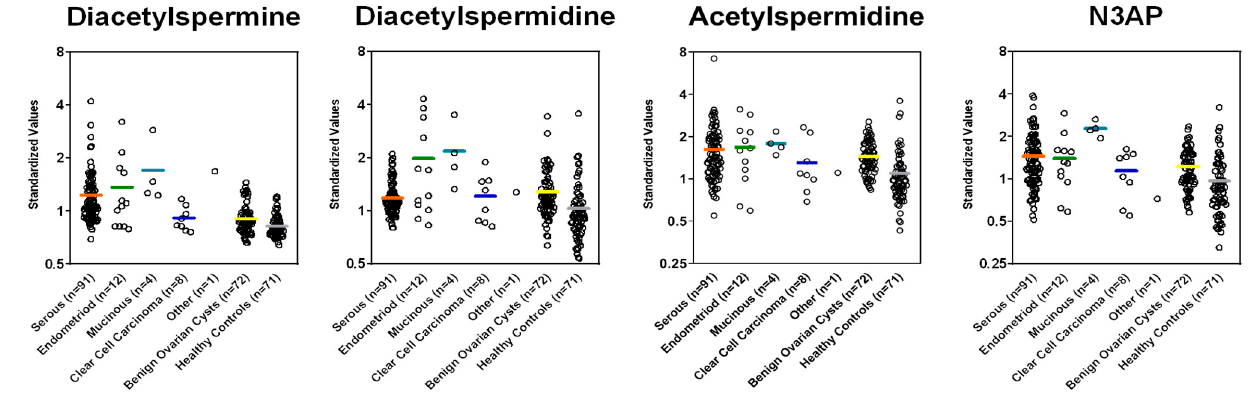
Figure A2. Plasma levels of polyamines in cases stratified by histology and controls in the Test Set.